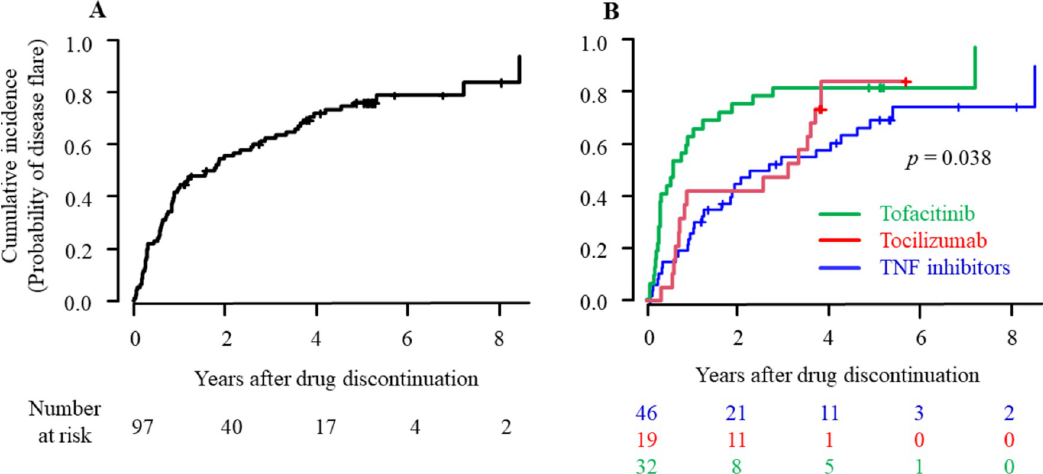
Fig 2. Cumulative incidence of disease flare after the discontinuation of bDMARDs and tofacitinib. CIF plots for the probability of patients who experienced disease flare following drug discontinuation are shown for all patients (A) and patients grouped according to the previous drugs (B). The cumulative flare probability over time among the patient groups were compared using Gray’s test with the post hoc Holm’s procedure. The p values are as follows: p = 0.038 for a comparison among the three groups; p = 0.023 for tofacitinib versus TNF inhibitors; p = 0.14 for tocilizumab versus tofacitinib; and p = 0.53 for TNF inhibitors versus tocilizumab. Numbers below this figure represent the number of patients remaining in the analysis. CIF, cumulative incidence function; bDMARDs, biological disease-modifying antirheumatic drugs; TNF, tumor necrosis